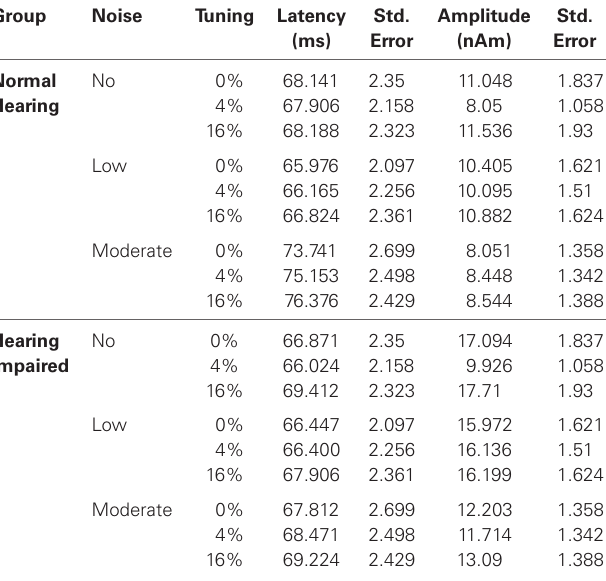
hearing group ( F ( 1,32 ) = 4.89, P = 0.03, η 2 = 0.13). Furthermore, Table 1 | Group mean P1m latency and